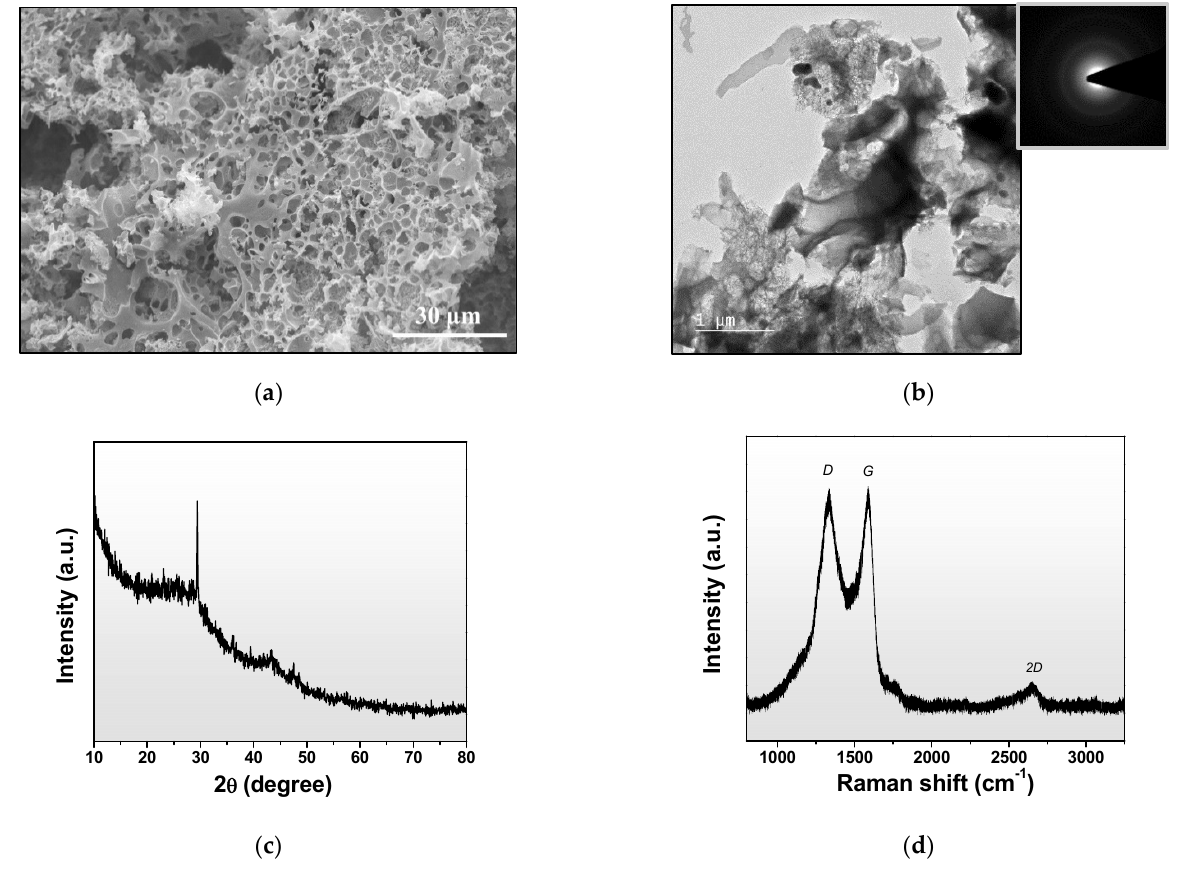
Figure 5. ( a ) SEM image, ( b ) TEM image, ( c ) XRD pattern, and ( d ) Raman spectrum of activated carbon derived from human hair (ACH).